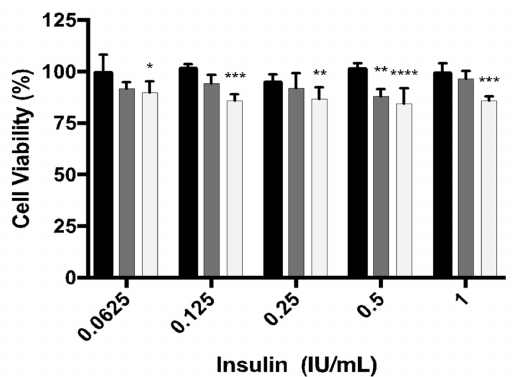
Figure 7. Cell viability (%) of cells treated with double-coated insulin-loaded NPs (empty columns), double-coated empty NPs (grey columns) and non-encapsulated insulin (full columns). The NPs concentrations tested ranged from 0.0625 to 1 IU / mL. The results were presented regarding the mean value ± SD (* p < 0.0332; ** p < 0.0021; *** p < 0.0002; **** p < 0.0001).